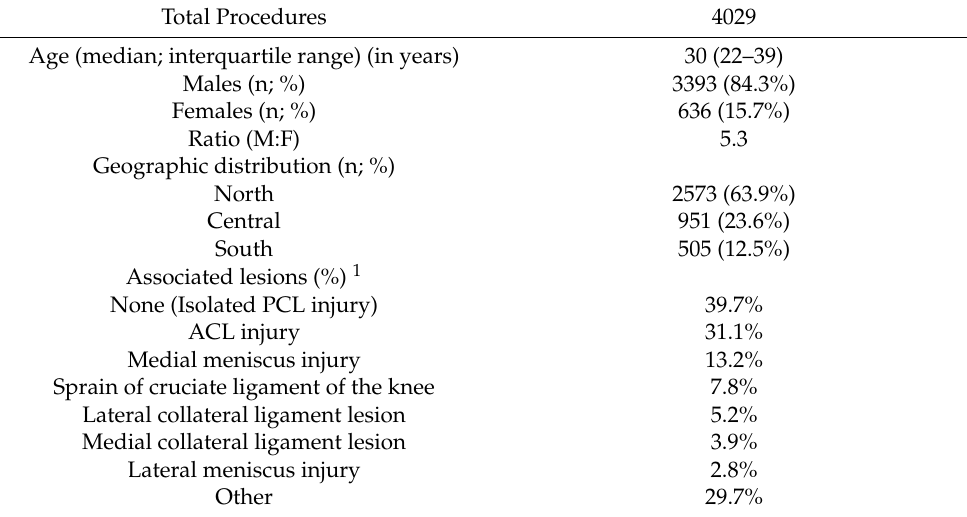
Table 1. Demographic